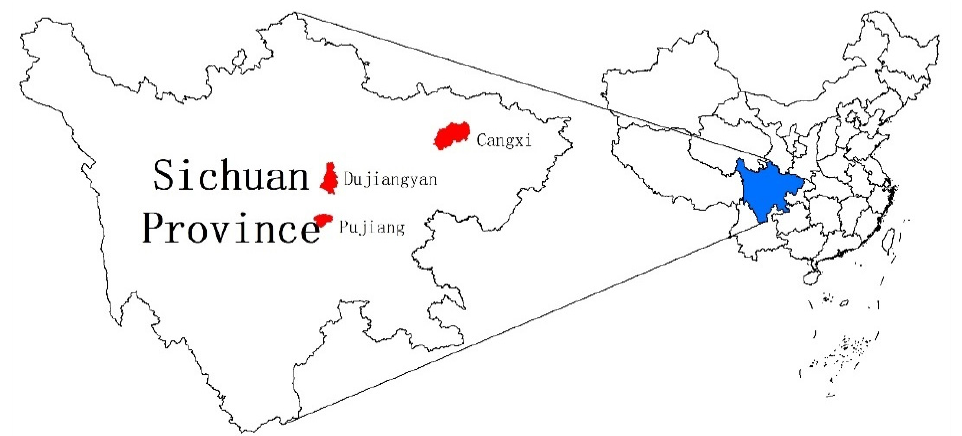
Figure 1. Map of the study area.